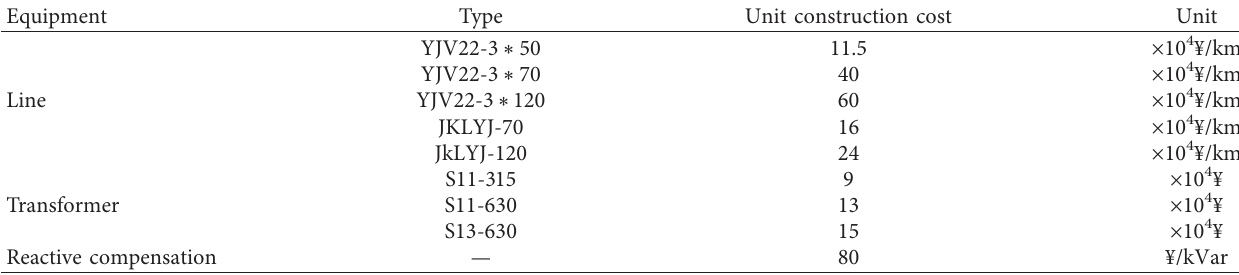
Table 5: Unit construction cost of related power equipment.